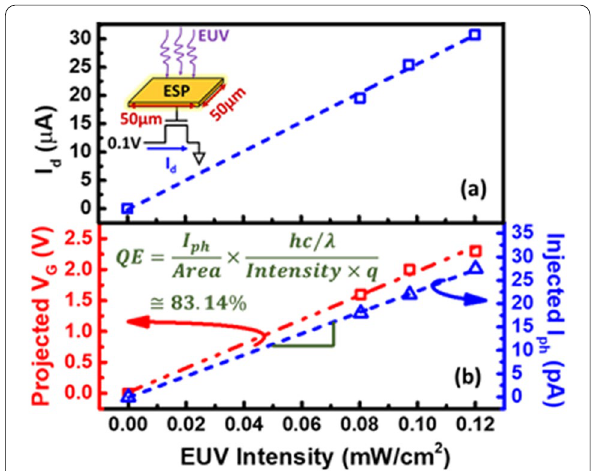
Fig. 7 The a measured data and b the photocurrent response induced by EUV light, projected by this